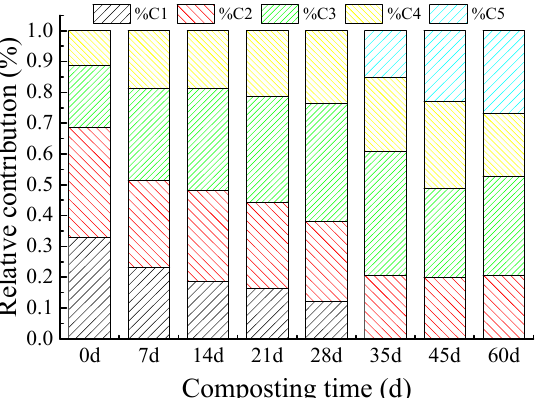
Figure 2. The relative concentration changes in identified DOM PARAFAC components on composting days 1, 7, 14, 21, 28, 35, 45, and 60.